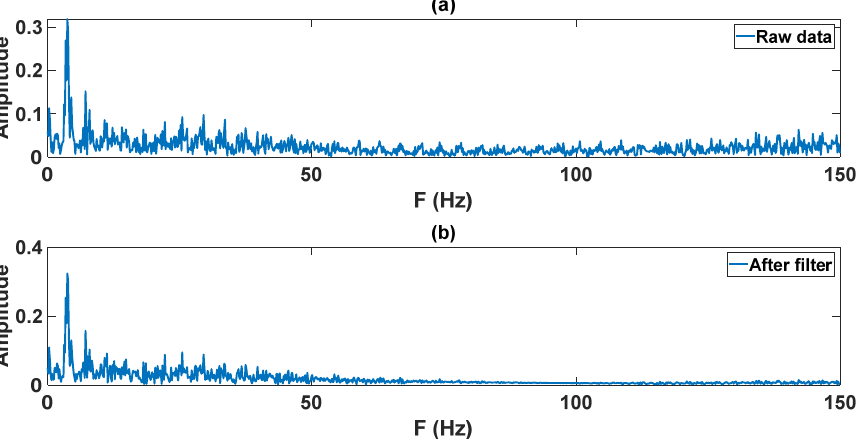
algorithm detecting the EMG signal and generating the peak pulse. The blue line is the EMG value, the pink dotted line is the initial value of the EMG, and the red dotted line is ling the actions of the VR figure. the peak pulse generated after the peak is detected. The peak pulse is used for controlling the actions of the VR figure.